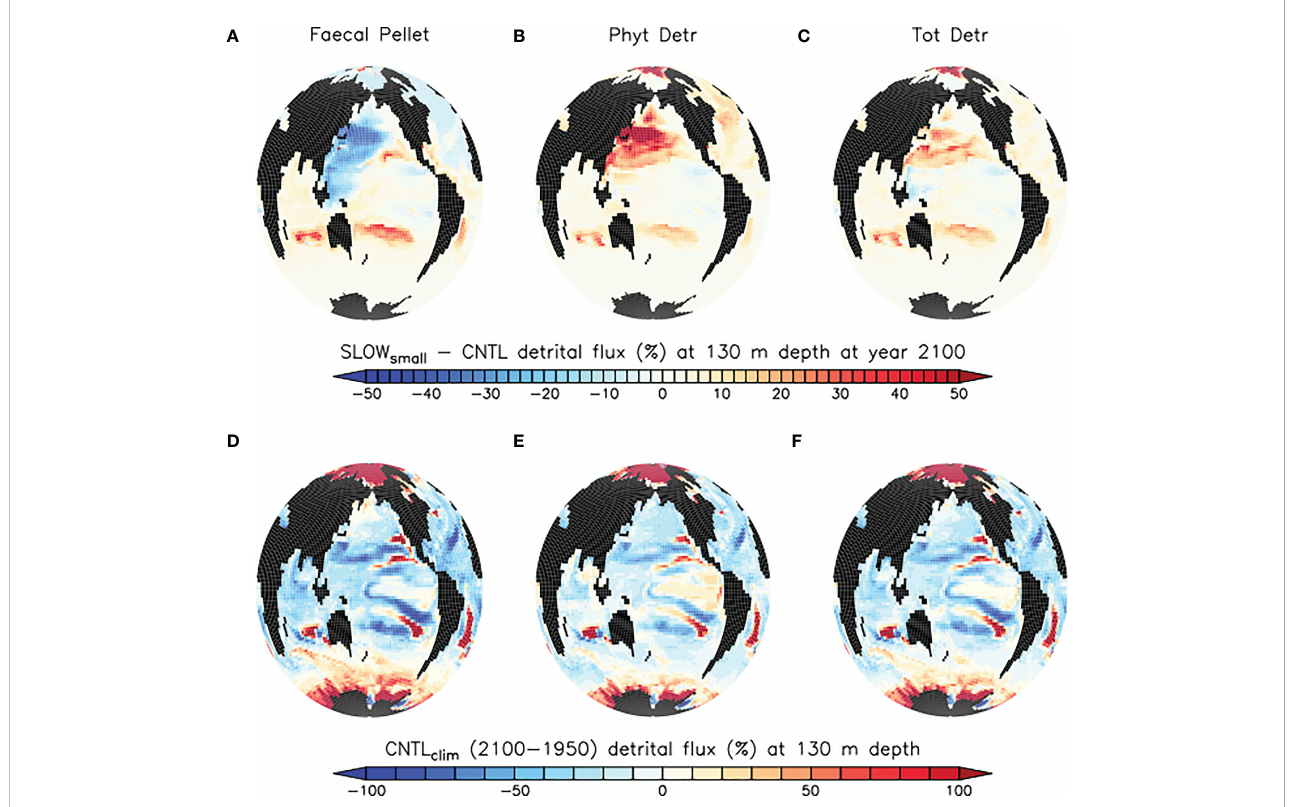
FIGURE 12 (A – C) model ensemble mean differences (SLOW small - CNTL) in simulated organic particle fl ux at 130 m depth at the year 2100, normalised against CNTL and provided as a percentage. (D – F) changes in particle fl ux arising due to climate change, CNTL clim years 2100-1950. Note the different scales applied to top and bottom row